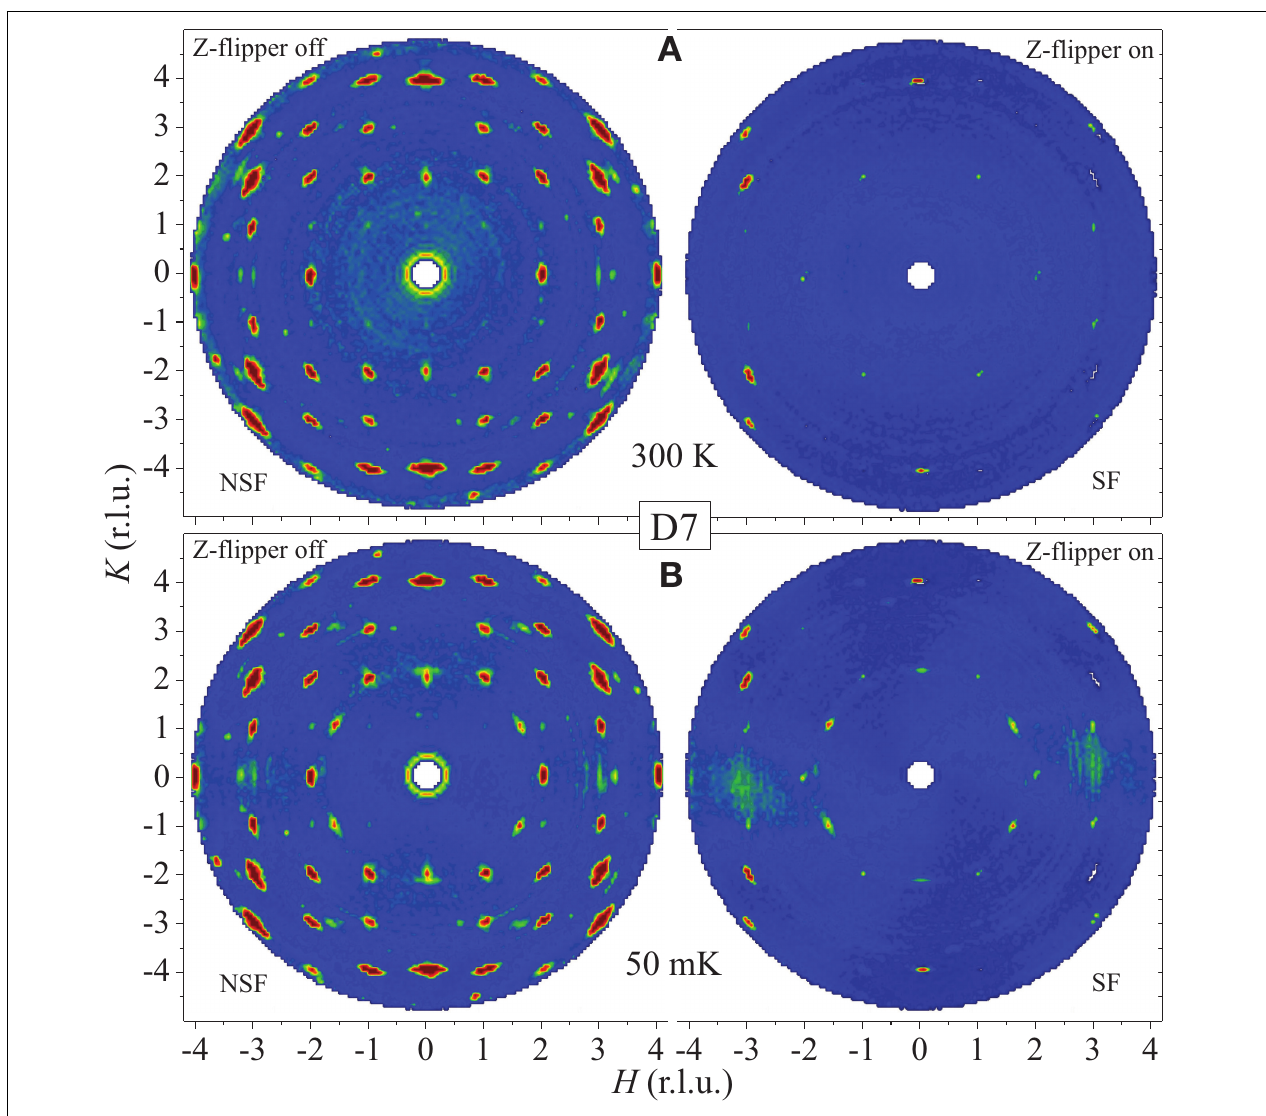
FIGURE 1 | Polarization analysis data measured using D7 (ILL). (A) At 300K. (B) At 50mK. The NSF (i.e., Z-flipper off, left panel) and SF (i.e., Z-flipper on, right panel) channels are shown with the same color code for intensity. The non-perfect polarization involuntarily leads to the presence of some nuclear Bragg peaks, e.g., (0, ± 4, 0), in the SF channel at both